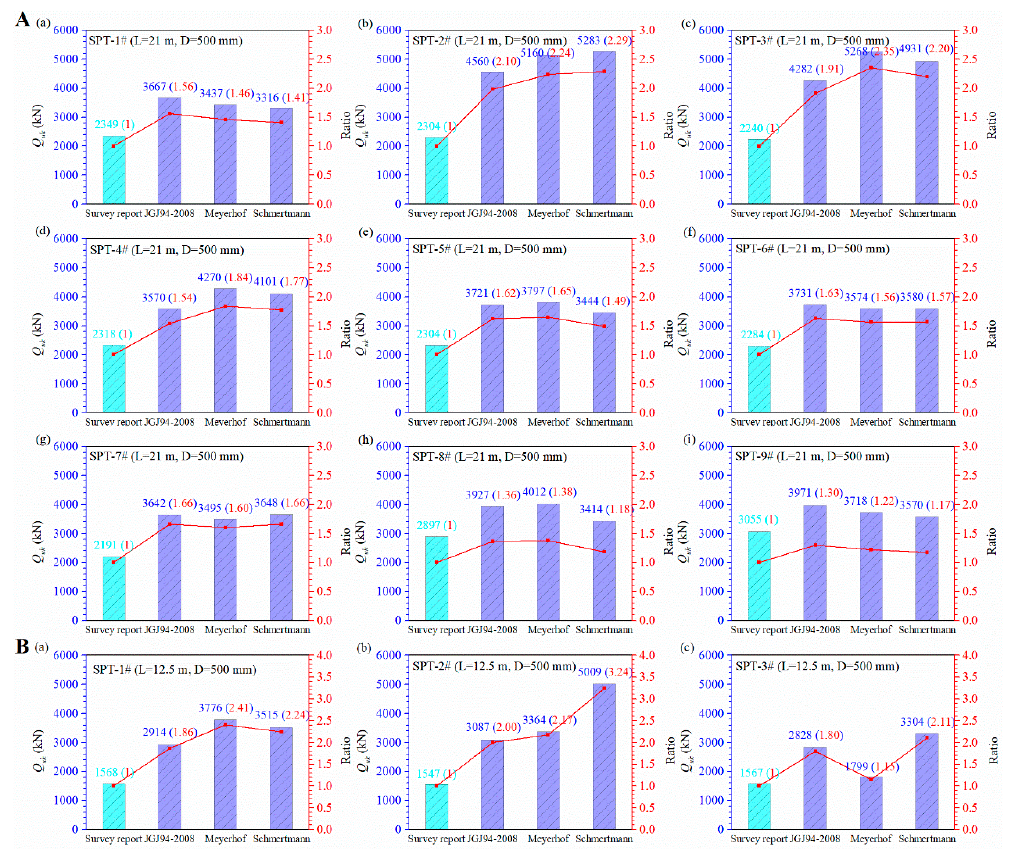
Figure 7. ( A ): The ultimate bearing capacity of long PHC pipe pile (L=21 m, D=500 mm); ( B ): The Figure 7. ( A ) The ultimate bearing capacity of long PHC pipe pile (L = 21 m, D = 500 mm); ultimate bearing capacity of short PHC pipe pile (L=12.5 m, D=500 mm). ( B ) The ultimate bearing capacity of short PHC pipe pile (L = 12.5 m, D = 500